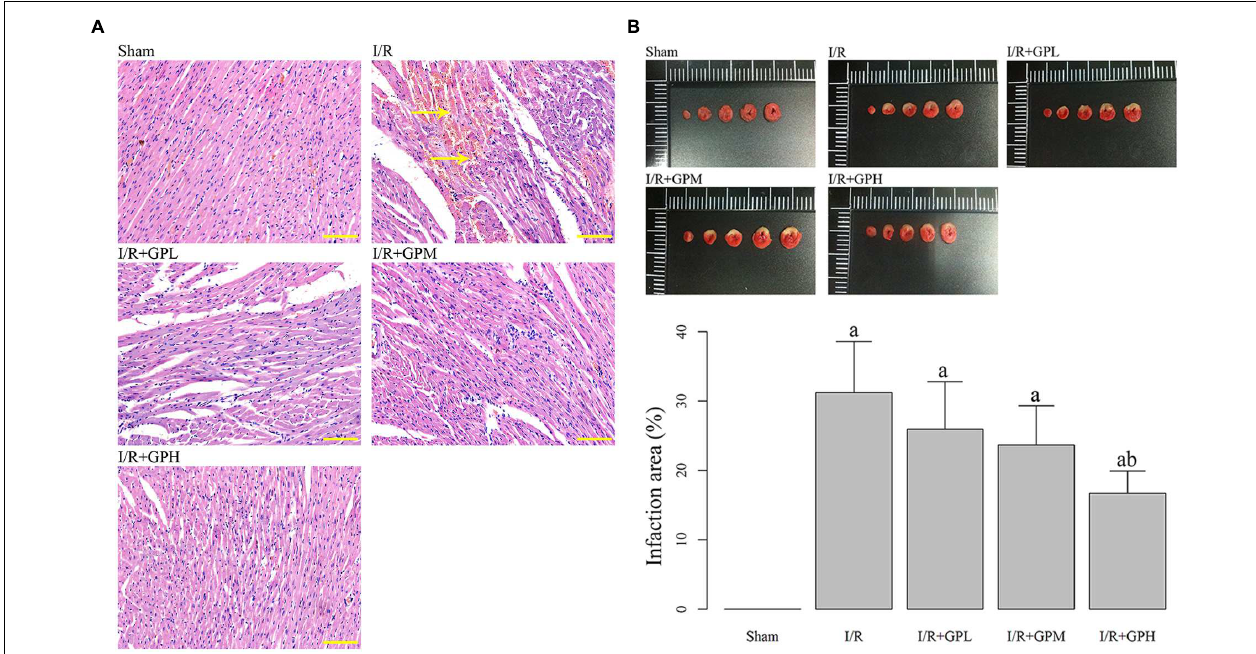
FIGURE 1 | Administration of gypenoside (GP) alleviated the impairments in myocardial tissues due to I/R injury. (A) Illustration of hematoxylin and eosin (H&E) staining of the myocardial tissues in different rats groups: the nuclei in myocardial tissue were stained blue and cytoplasm were stained red. Arrows indicating the demolition of cell structure. Scale bar: 100 µ m. (B) Treatment with GP significantly decrease the infarct area caused by I/R injury. a, significantly different from sham group, P < 0.05. b, significantly different from I/R group, P < 0.05.